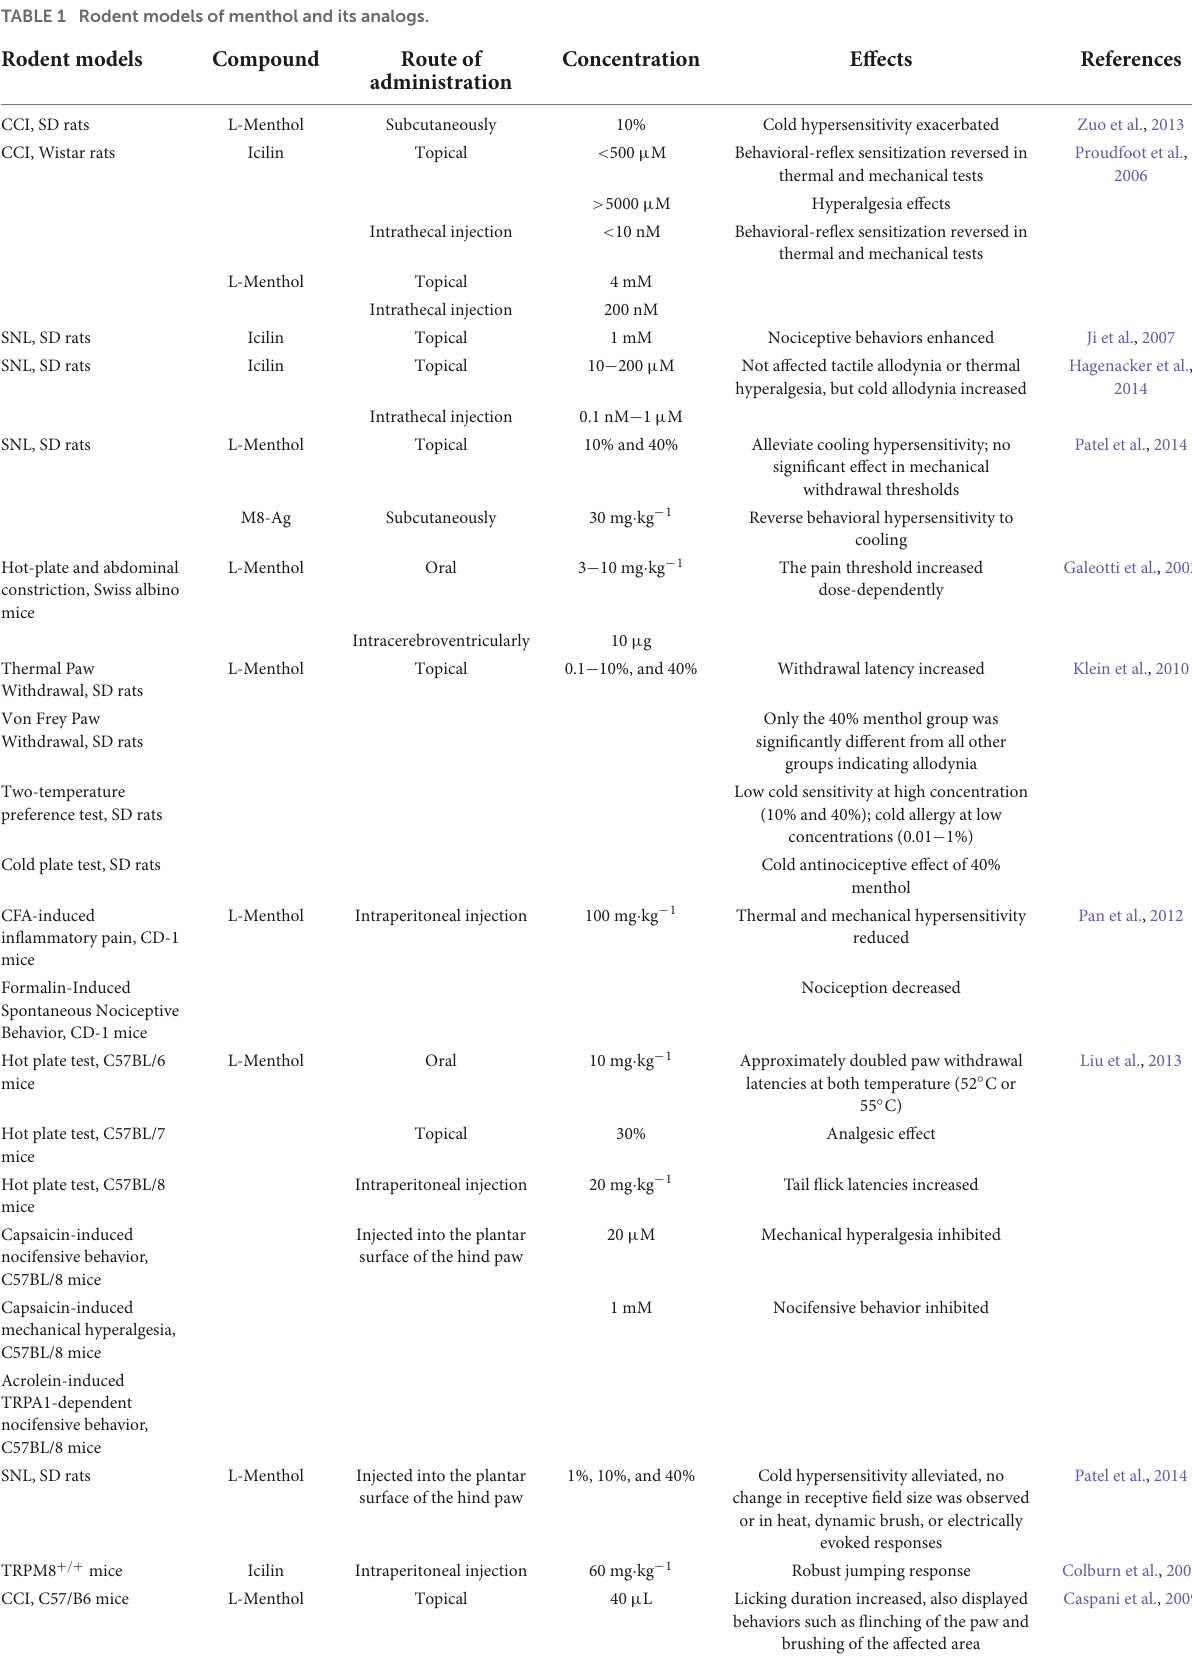
TABLE 1 Rodent models of menthol and its analogs. Rodent